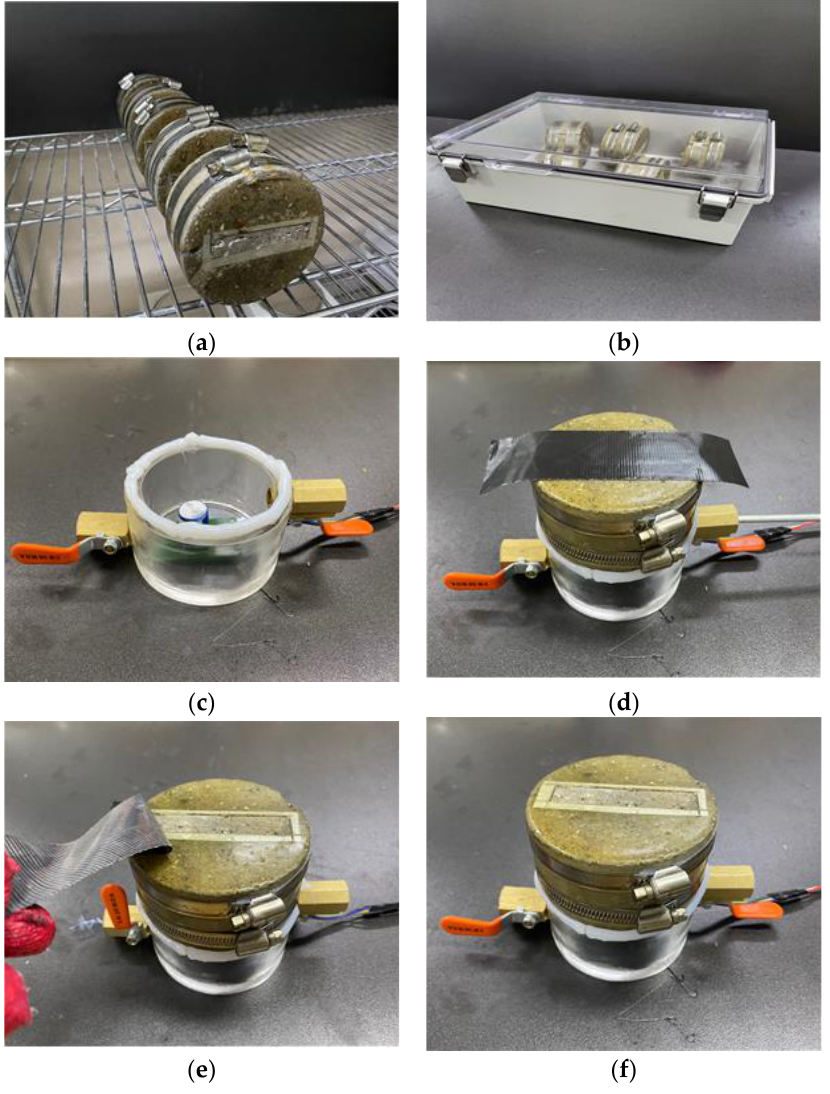
Figure 6. Experimental processes: ( a ) specimen creation; ( b ) pre-stabilization; ( c ) vacuum grease application; ( d ) specimen mounting and nitrogen injection; ( e ) tape removal during measurement; and ( f ) measurement following tape removal.